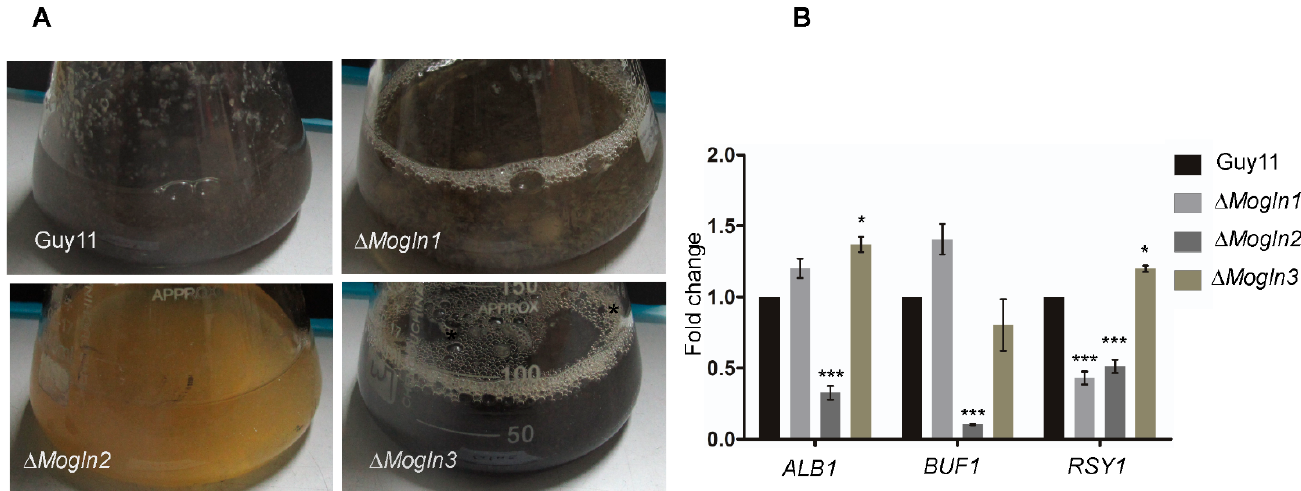
Figure 12. MoGLN2 is required for hyphal melanization in M. oryzae. ( A ) Mycelial growth in liquid CM medium showing impaired hyphal melanization as a result of MoGLN2 gene. ( B ) qRT-PCR analysis of the expression levels of genes important for melanin biosynthesis in mycelium grown in liquid CM. Error bars denote the standard deviations from means obtained from three independent replicates. Asterisks indicate statistically significant differences (*, p < 0.005; ***, p < 0.001; one-way ANOVA was used to analyze data with Tukey’s multiple-comparison test in GraphPad Prism 8 ).